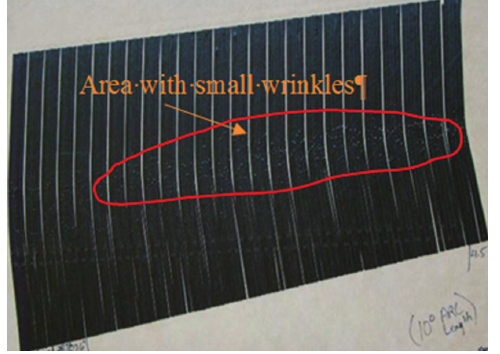
Figure 11 Fiber steering trial case 2: θ = 10 ° , ply 2, laid down at 10.7 m/min.